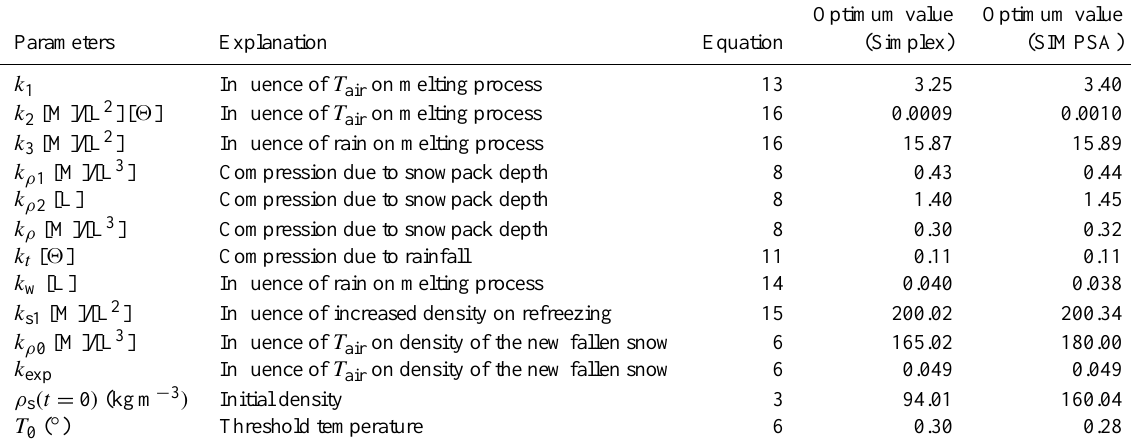
Table 1. The optimal configuration of SAMM obtained with two different parametric identification techniques.